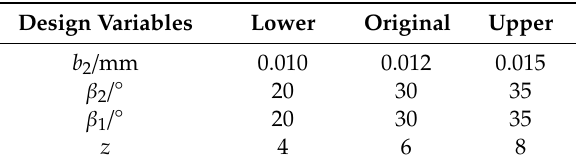
Table 5. Ranges of design parameters.